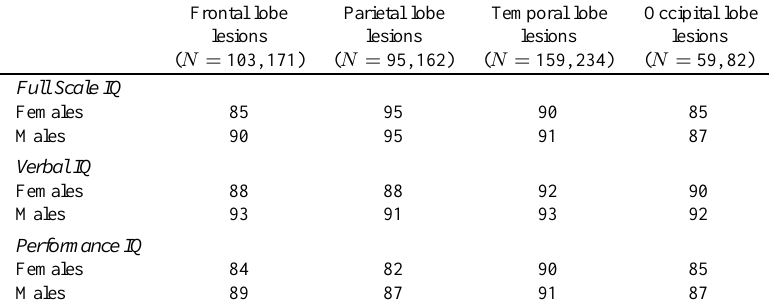
Table 6 Mean intelligence quotients (FSIQ, VIQ, PIQ) and number of cases as a function of